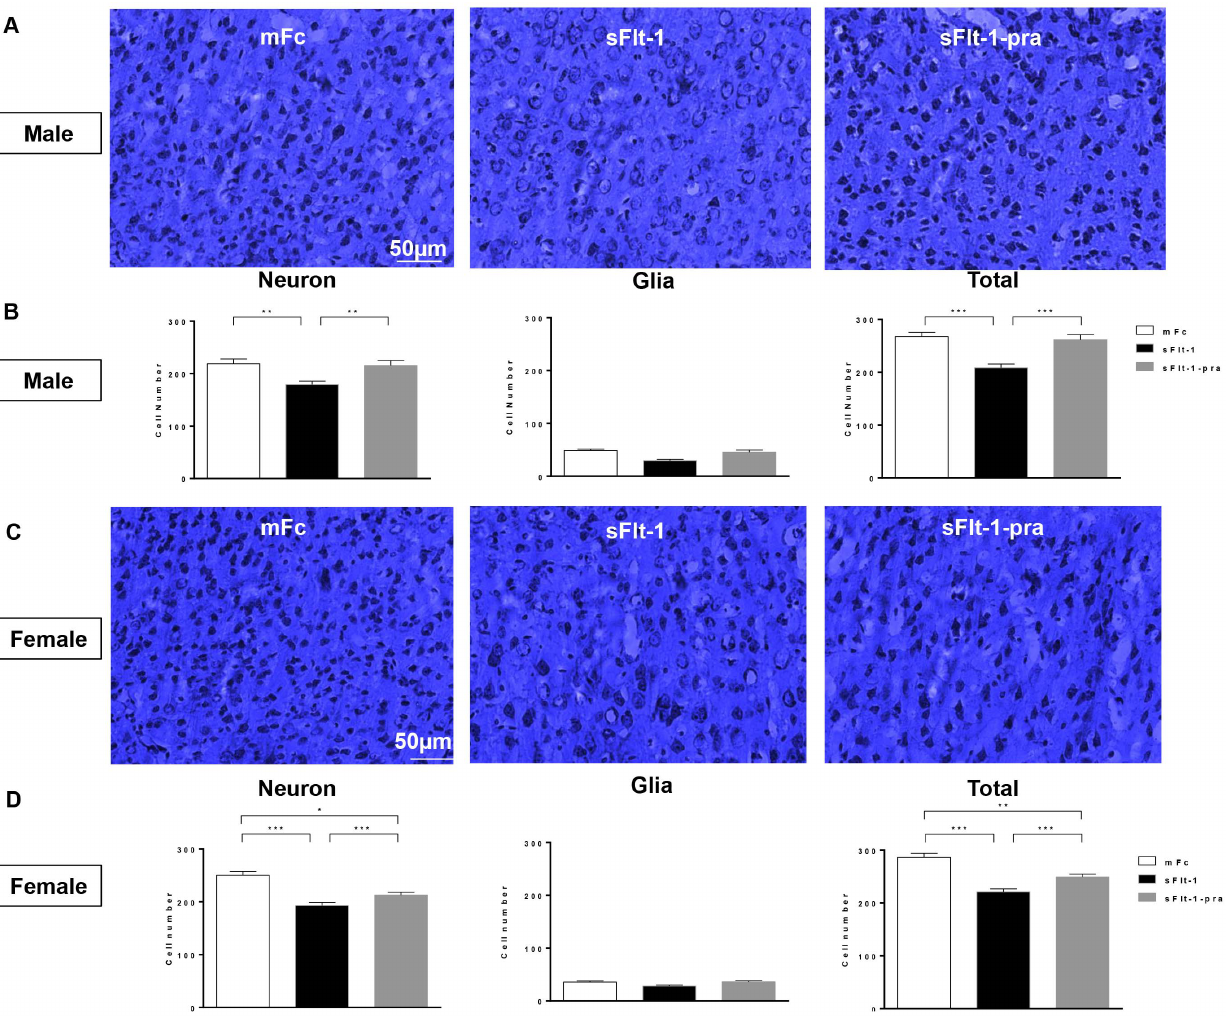
Figure 4. Altered Cortical Cell Counts in 6 Month Old Offspring Brain. Nissl staining of neocortex of 6 month old mice offspring shown here at 40 X magnification in panels A (male) and C (female). Neurons were identified by dark-blue positive staining. Glial cells were smaller than neurons and had darker nuclei but no clearly visible Nissl bodies in the cytoplasm. A decrease in positive staining is seen male and female sFlt-1 offspring (A: sFlt-1, C: sFlt-1) when compared to controls (A: mFc, C: mFc) and pravastatin treatment group offspring (A: sFlt-1-pra, C: sFlt-1-pra). Total cell count as well as neuronal and glial cell counts were performed on randomly chosen 7-8 fields in the frontal cortex per animal and analyzed by 2-way ANOVA (n=3 for all groups by gender). Data are reported as mean 6 SEM. Male data are seen in Panel B, and female data in Panel D. Significant decreases in total cell count are seen in both male and female sFlt-1 offspring when compared to controls (p , 0.0001) and sFlt-1-pra (male and female p , 0.0001), though the female sFlt-1-pra group remained significantly different from mFc controls (p=0.001). There is no difference in glial cell count between all three groups. Neuronal cell count appears to drive this total cell count difference. The male sFlt-1 offspring (B) show a significant decrease in neurons when compared to mFc controls (p=0.0003) and sFlt-1-pra offspring (p=0.001). Female sFlt-1 offspring (D) show a similar drop in neuronal count versus mFc controls and sFlt-1-pra offspring (p , 0.0001), with pravastatin-exposed offspring remain significantly different from mFc controls